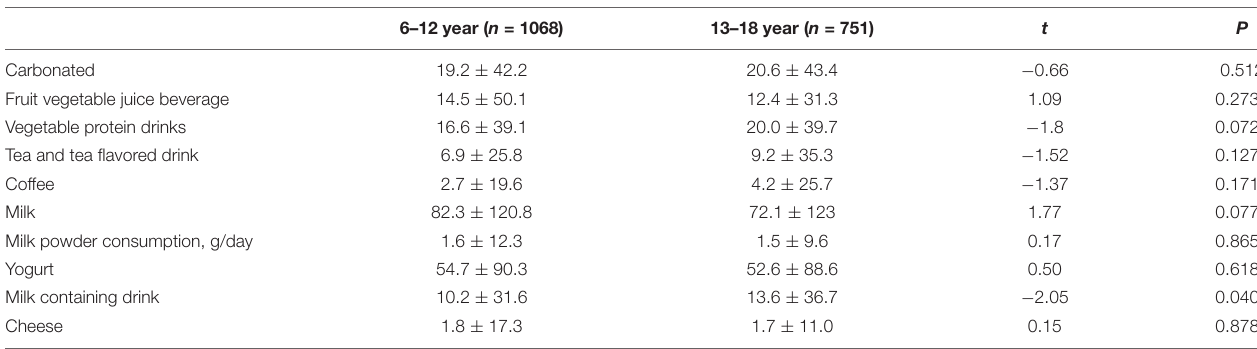
TABLE 2 | Consumption of various types of SSBs in children and adolescents (mean ±